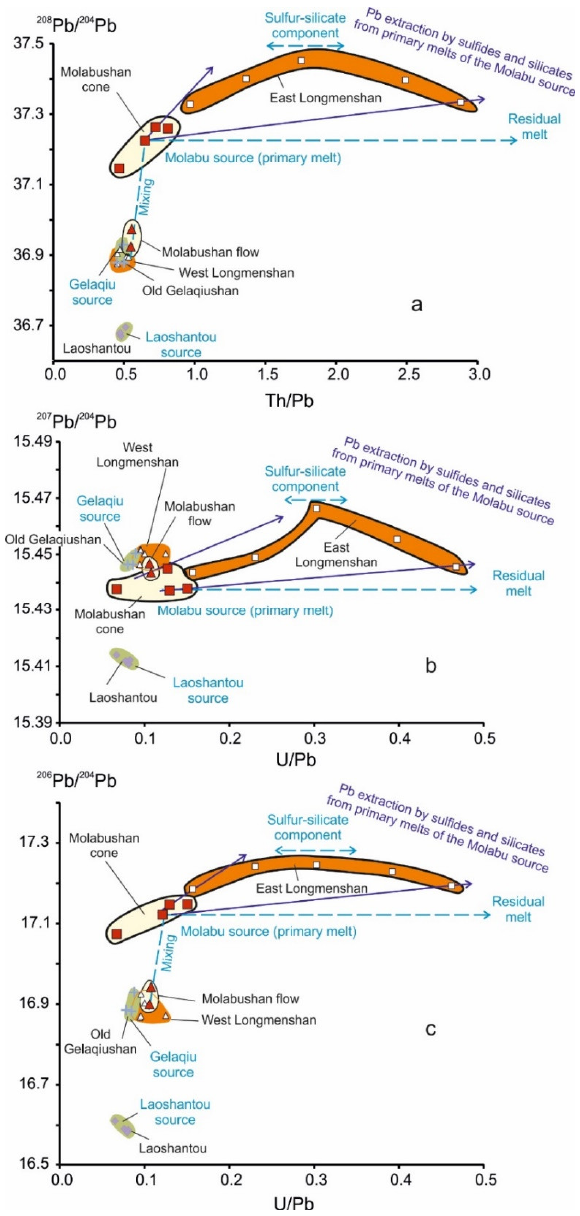
Figure 12. 208 Pb/ 204 Pb versus Th/U ( a ) and 206 Pb/ 204 Pb, 207 Pb/ 204 Pb versus U/Pb ( b , c ). Symbols are as in Figure 5. The two purple arrows in each graph indicate an array of modified compositions resulting from the introduction of the sulfur-silicate component with elevated Pb isotopic ratios into the primary melt of the Molabu source.